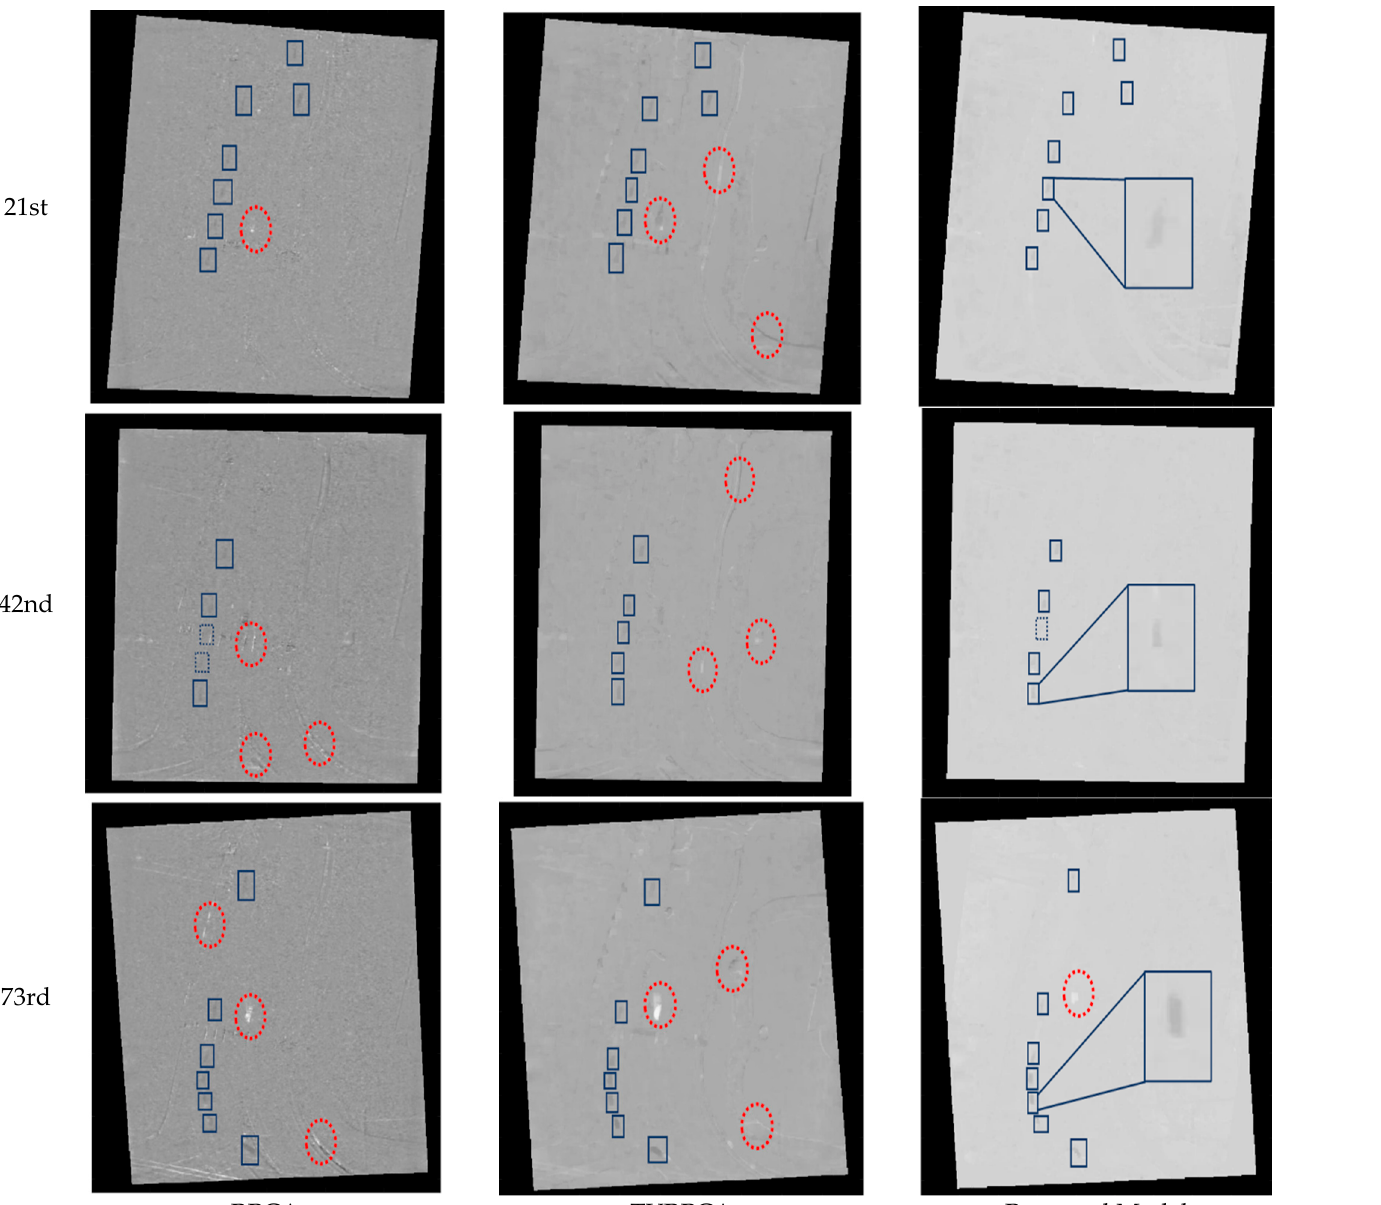
Figure 5. Comparison of improved